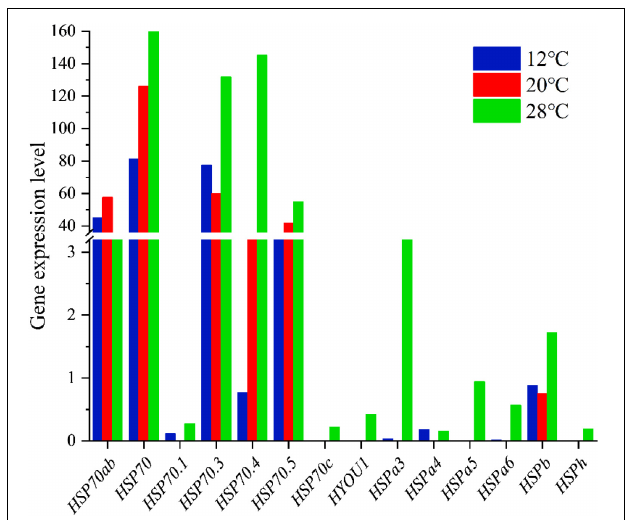
FIGURE 6 | The histogram visualizes the expression level of the HSP70 gene family in the C. japonica s at three temperature gradients.